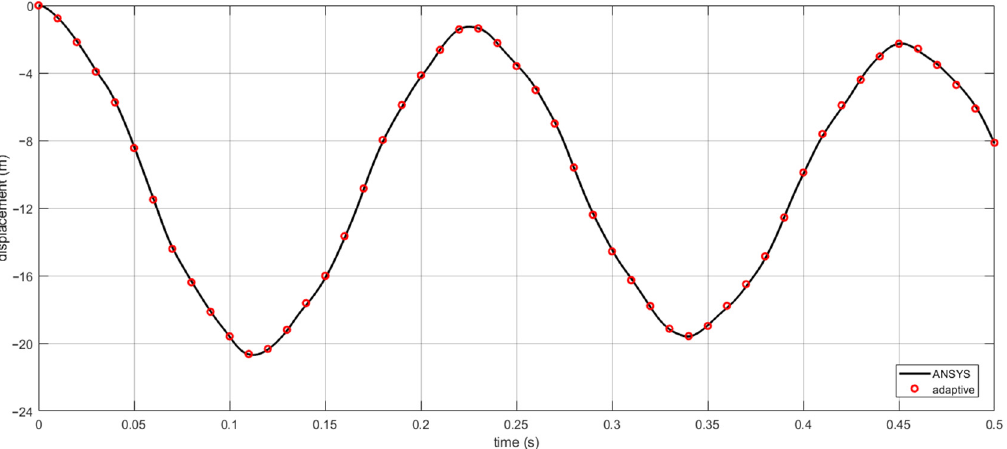
Figure 14. The transient vertical displacement at point A with damping ( c = 1 Ns/m), ∆ t = 0.005 s, under Heaviside step loading with an infinite duration.